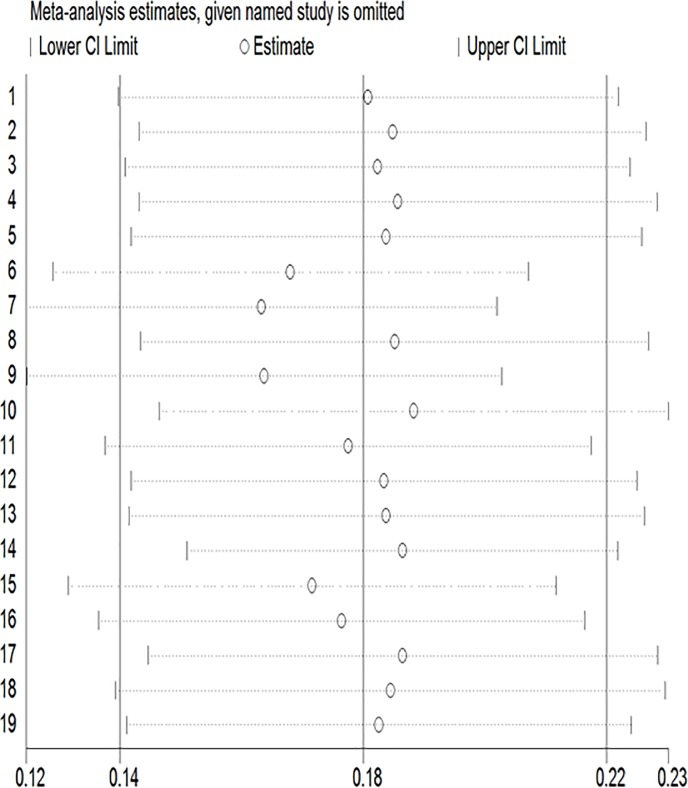
Sensitivity analysis between postnatal depressions studies included in a meta-analysis.